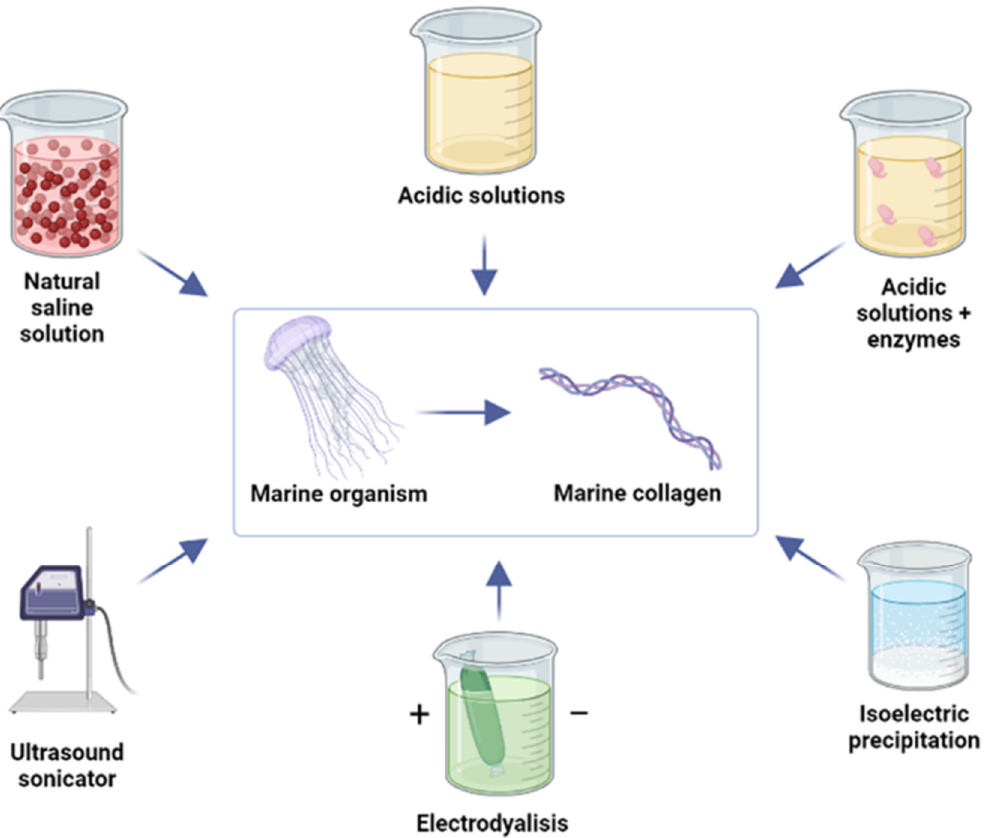
Figure 4. Collagen extraction methods: neutral saline solutions, acidic solutions, acidic solutions with added enzymes, ultrasound sonication, electrodialysis, and isoelectric precipitation. Created with BioRender.com.